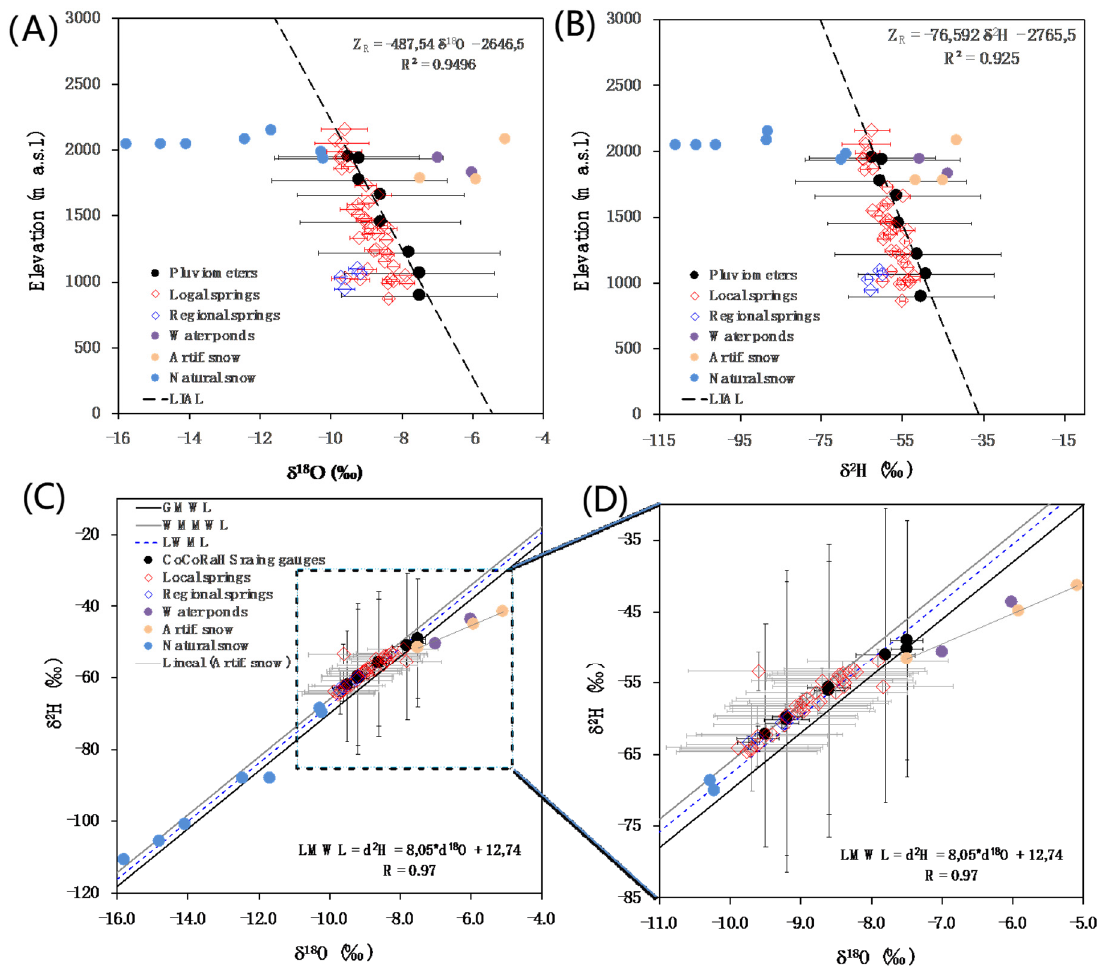
Figure A3. ( A ) H and O stable isotope composition water lines derived in [29] used to infer recharge altitudes for the whole dataset. ( A ) Relationship between elevation and δ 18 O content, where LIAL is the local isotope altitudinal line; ( B ) Relationship between elevation and δ 2 H content; ( C ) Relationship between δ 2 H vs. δ 18 O content and ( D ), zoom in the graph δ 2 H vs. δ 18 O. GWML is the Global Water Meteoric Line WMMWL is West Mediterranean Meteoric Line and LWML is Local Water Meteoric